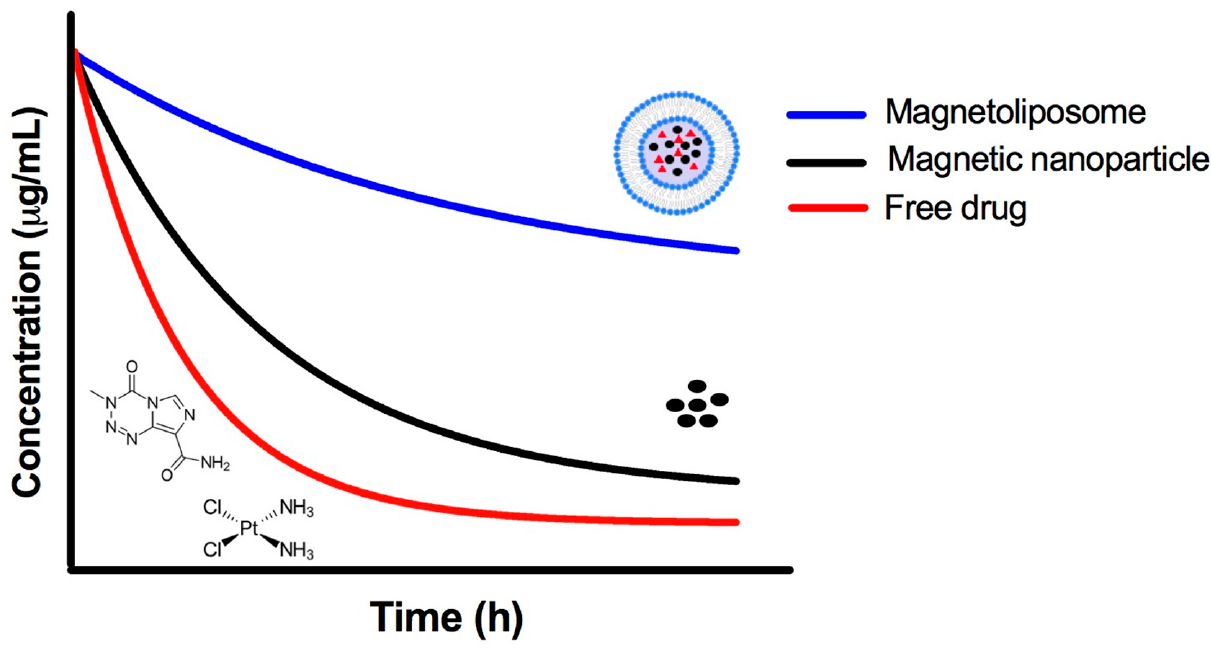
Figure 5. Bioavailability of the magnetoliposome. There is an advantage to the use of nanocarrier systems; when a drug is encapsulated, it is protected from the action of metabolic enzymes and therefore adopts the pharmacokinetics of the nanocarrier systems. There is a prolonged systemic circulation time of the nanocarrier, which implies a greater probability that the drug will reach the target organ or tissue where it is required to be